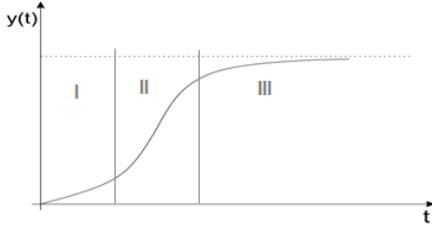
Figure 1. The evolution of yield of agricultural crops.